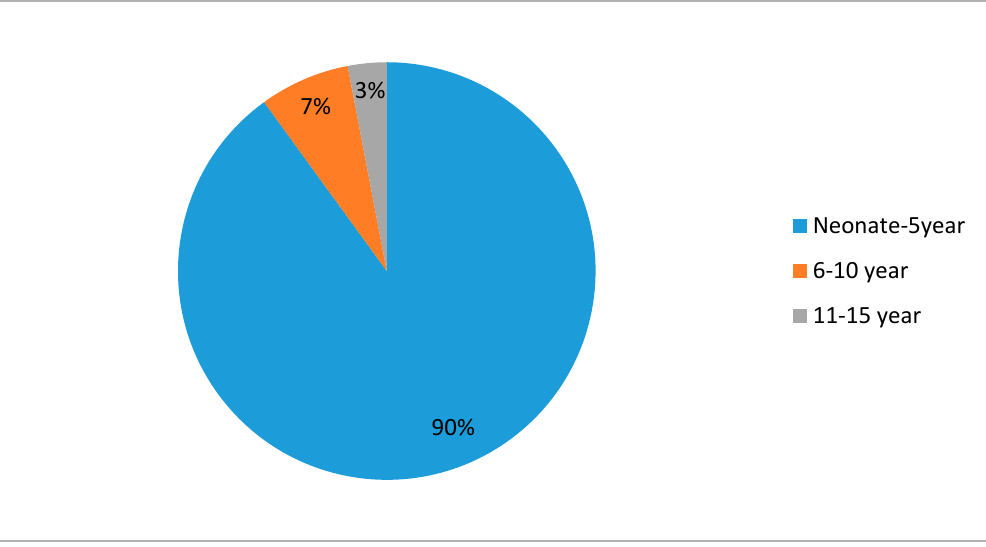
Figure 1. Percentages of children in different age groups.